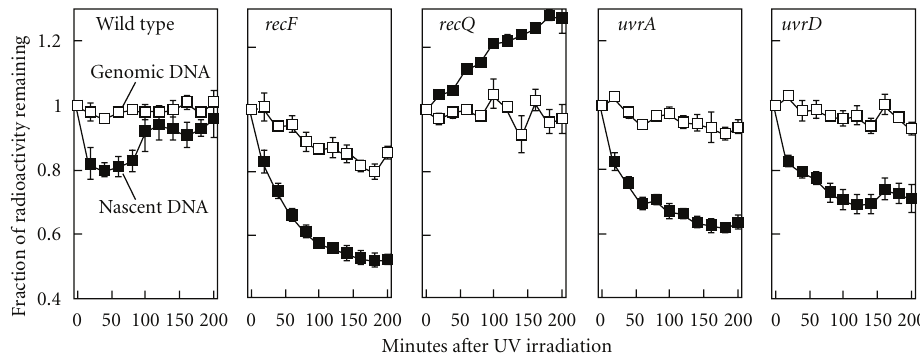
Figure 3: In the absence of UvrD, the nascent DNA at stalled replication forks is degraded in a manner similar to other repair mutants. [ 14 C]-thymine-labeled cultures were pulse-labeled with [ 3 H]-thymidine for 5s before the cells were collected, resuspended in nonradioactive media, and UV-irradiated with 27J/m 2 . The fraction of 14 C-labeled genomic DNA ( (cid:3) ) and 3 H-labeled nascent DNA ( (cid:2) ) remaining over time is plotted. Graphs represent the average of three independent experiments. The level of [ 3 H] and [ 14 C] in DNA immediately preceding irradiation ranged between 2500–7000 cpm and 1000–2500 cpm in all experiments. Error bars represent the standard error of the